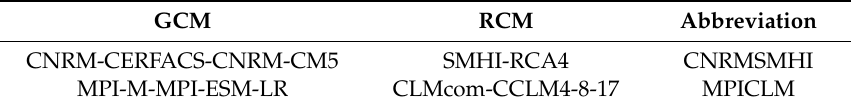
Table 4. List of the two EURO-CORDEX climate model chains selected for the present study. For each model chain the global climate model (GCM) and the regional climate model (RCM) are outlined, along with their abbreviation and relevant bibliographic